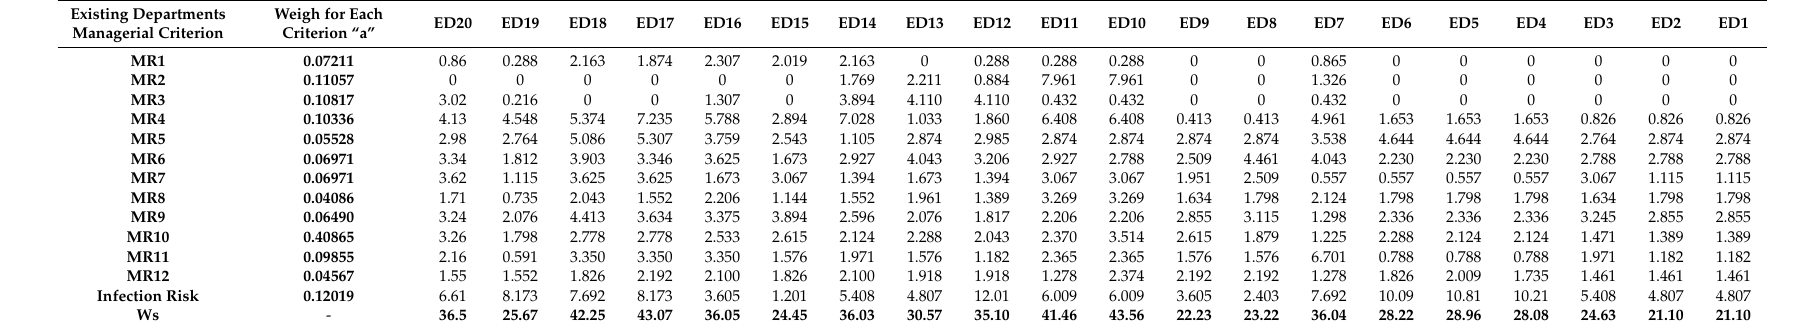
Table 3. Result of weighted sum method (WSM) matrix for removing